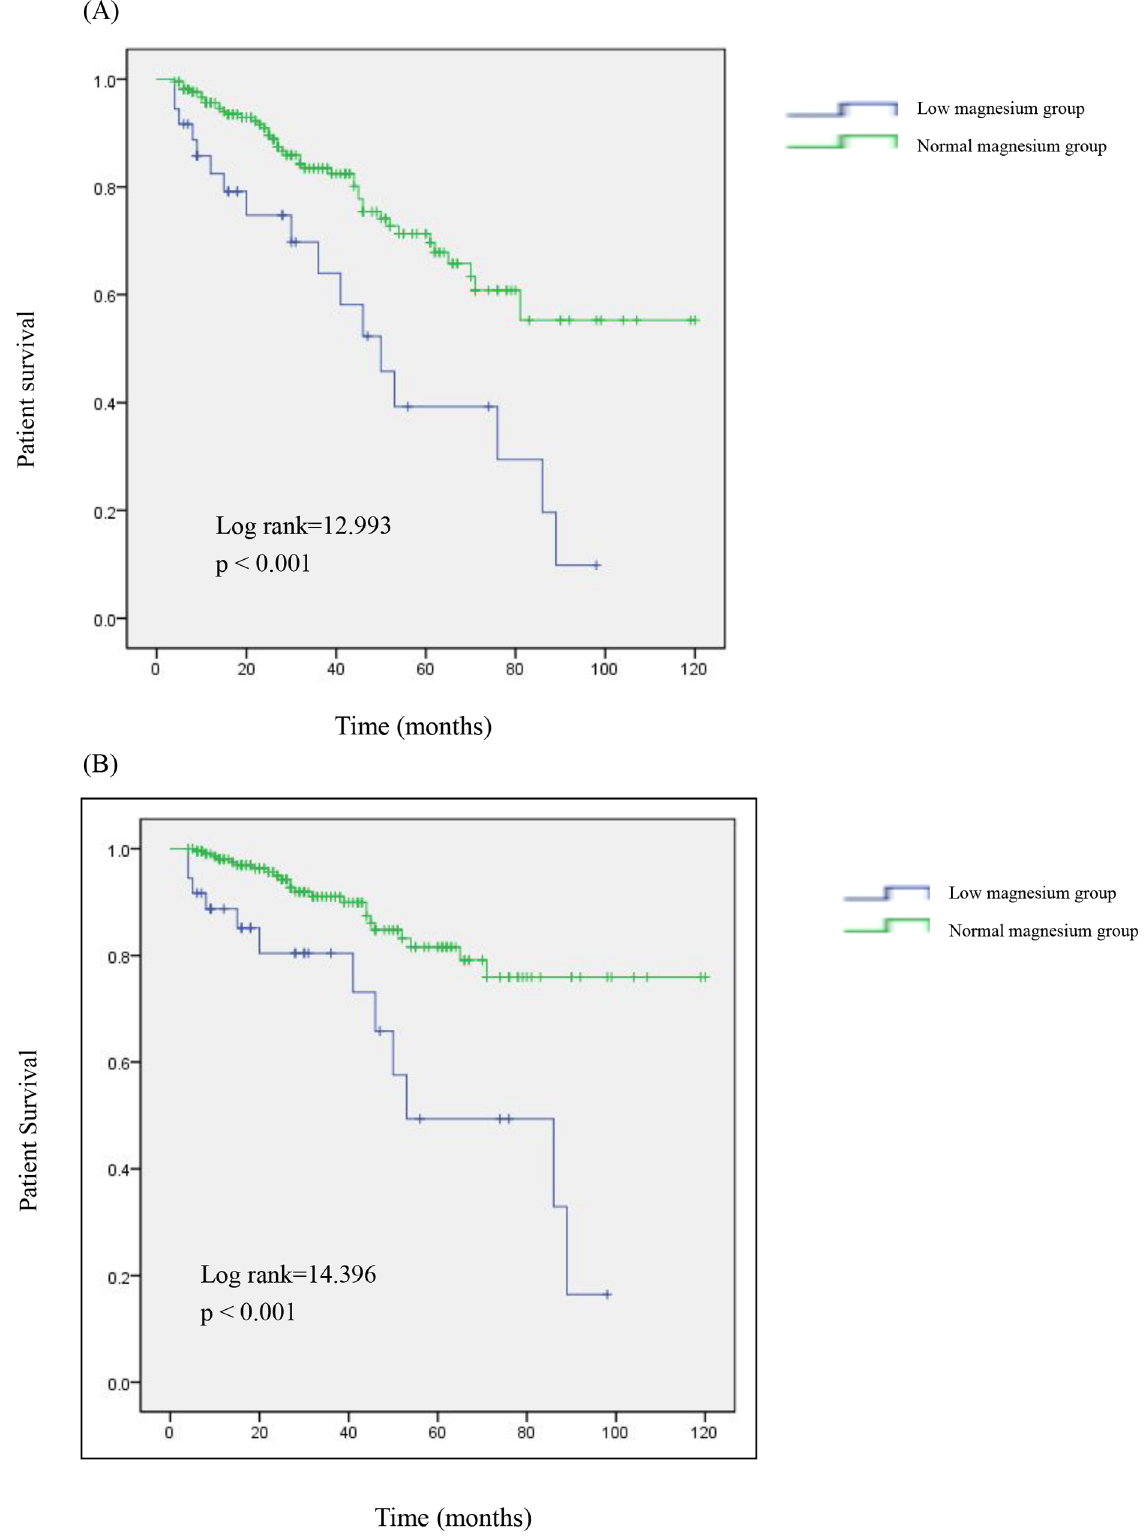
Fig 3. Survival curves for patients with different serum magnesium levels. Cumulative survival curves for (A) all-cause mortality and (B) cardiovascular mortality according to the category of baseline serum magnesium. doi:10.1371/journal.pone.0152488.g003 PLOS ONE | DOI:10.1371/journal.pone.0152488 March 29,